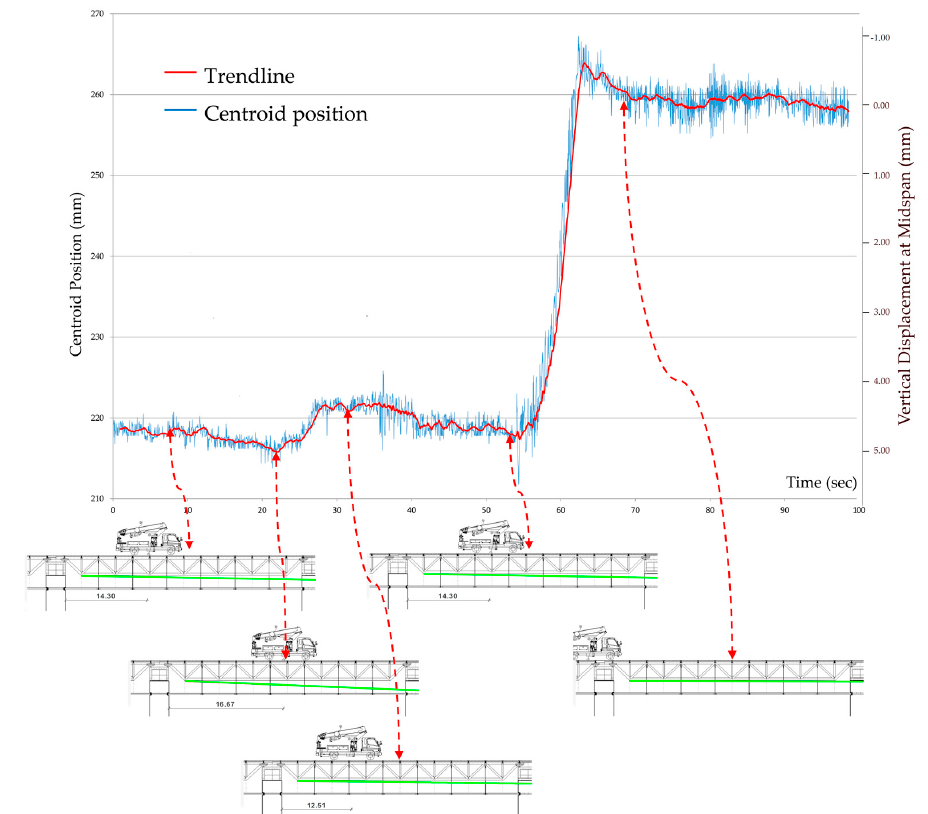
Figure 11. The vertical position of the centroid of the footprint during the test.